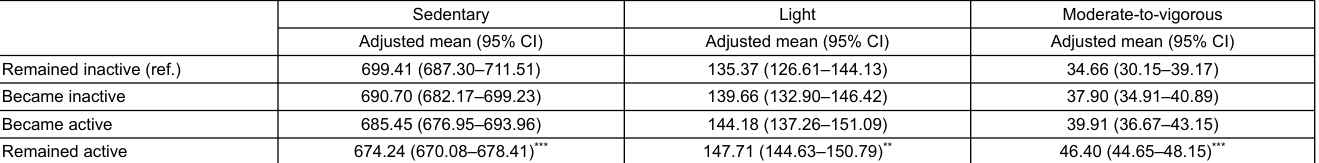
Table S4: Covariate adjusted mean minutes per day spent in specific levels of physical activity intensity objectively measured at SAPALDIA4, according to self-re- ported moderate-to-vigorous physical activity change patterns between SAPALDIA2 and SAPALDIA3 (remained active n = 87; became inactive n = 162; became ac- tive = 175; remained active = 729) according to Swiss recommendation for Physical Activity